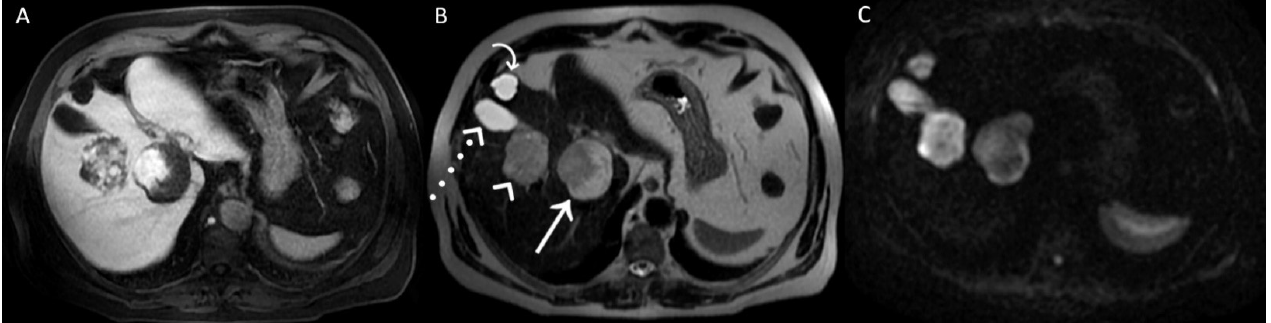
contrast T2WI and DWI in the detection and characterization of hepatic tumors [1,2]. In